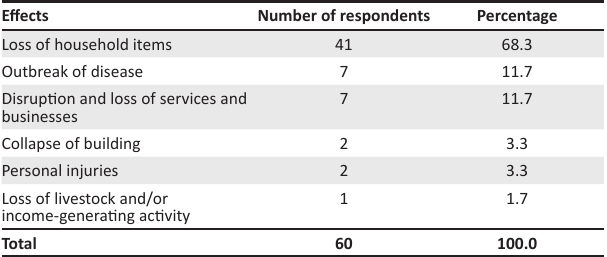
TABLE 1: Major effects of preceding floods on residents of